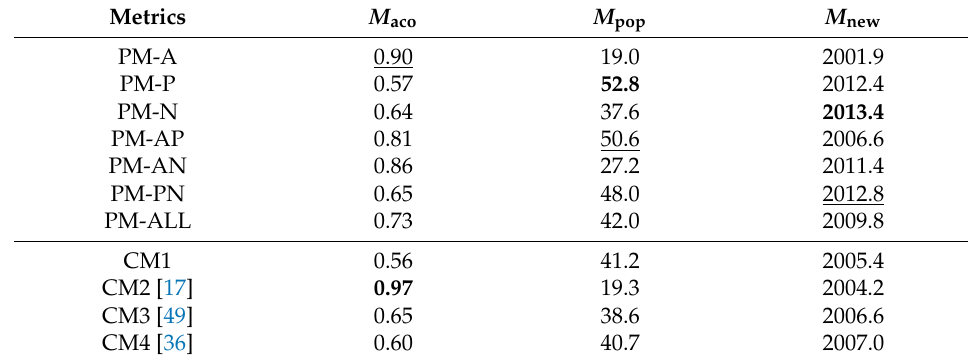
Table 3. The values of M aco , M pop , and M new . The bold and underlined values are the maximum and second highest values for each evaluation metrics, respectively